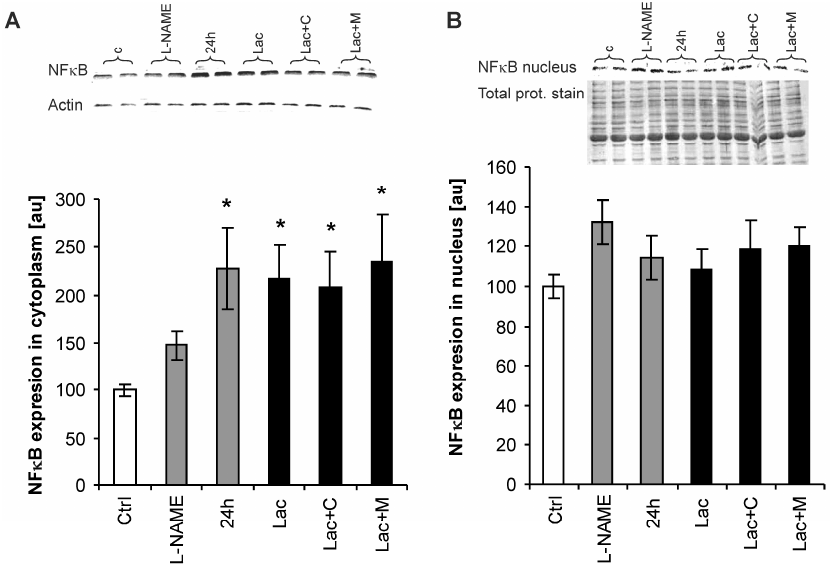
Figure 6. Cytoplasmatic ( A ) and nuclear ( B ) left ventricular NF- κ B expression in the control group (Ctrl), L-NAME (L-NAME)-, continuous 24 h/day light (24 h)-, lactacystin (Lac)-induced hypertension, and in lactacystin-hypertension influenced by captopril (Lac+C) or melatonin (Lac+M). * p < 0.05 vs. Ctrl.